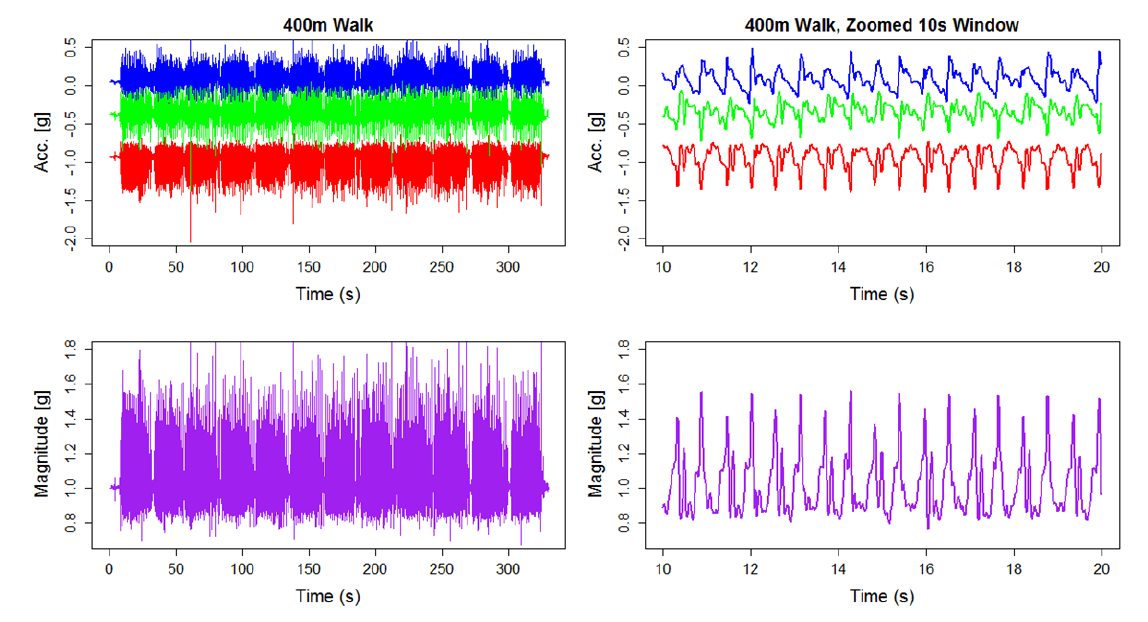
Figure 1. Triaxial accelerometer data from the 400 m walk for a single individual ( top left ) and a zoomed 10 s window ( top right ). Vector magnitude from the 400 m walk for same individual ( bottom left ) and zoomed 10 s window ( bottom right